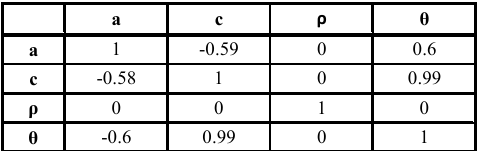
Table 3. Correlation coefficients of Model 2